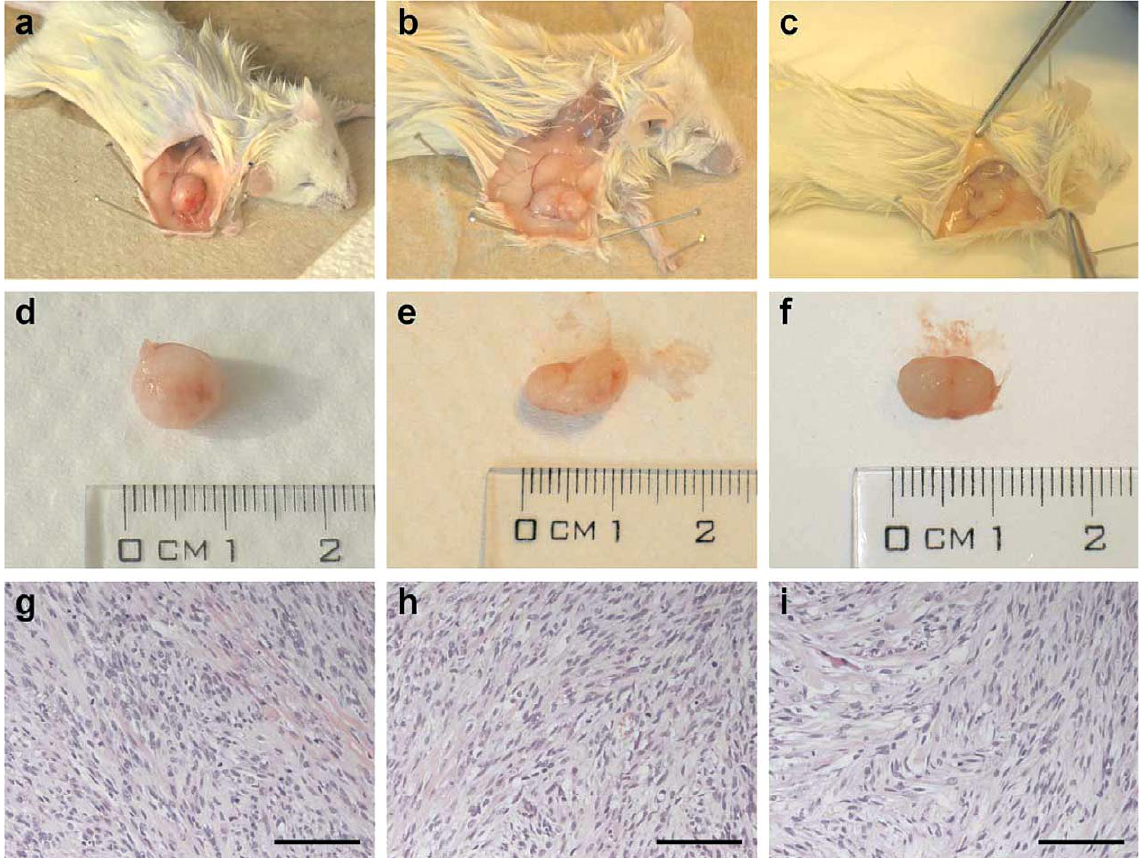
Fig. 8. Tumorigenicity in vivo assay using NSTS-11 cell line. Subcutaneous xenograft tumors in NOD/SCID mice at 81–84 days after injection of NSTS-11 cells (8a-c). Size of all three tumors was about 10mm in diameter (8d-f). Histological examination of these tumors showed a pattern corresponding to the diagnosis of embryonal rhabdomyosarcoma; bars, 200 (cid:1) m